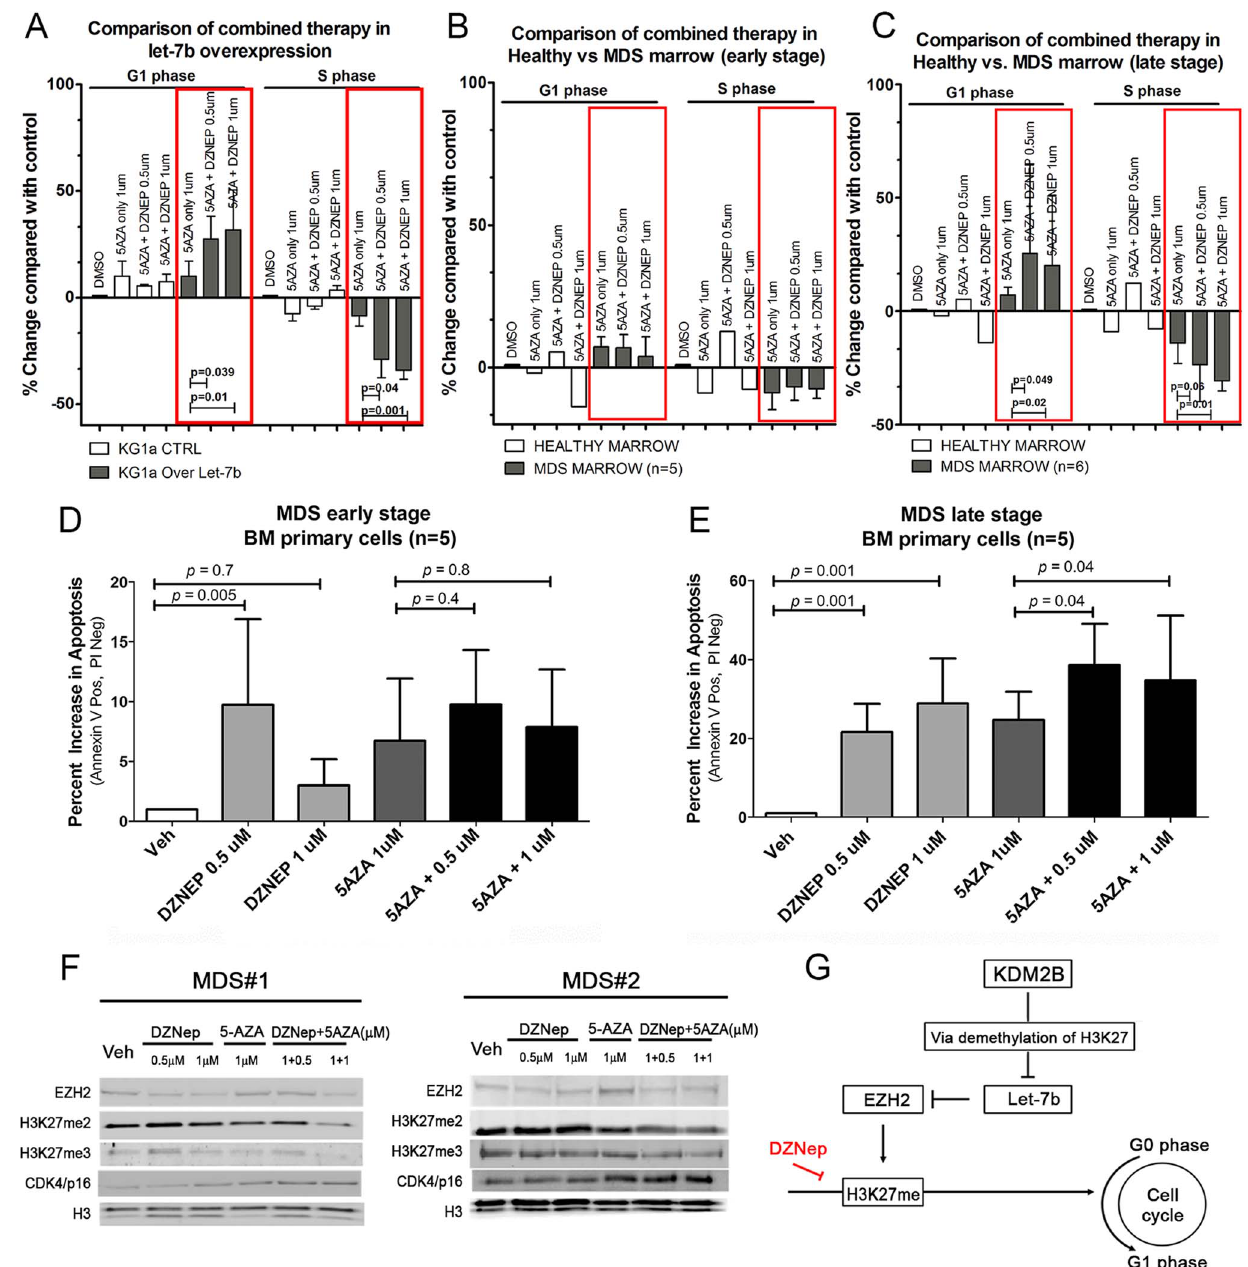
Figure 6. Response of cell lines and primary marrow cells to DZNep and 5AZA. Proliferation study in, A ) KG1a cells overexpressing let-7b, B ) primary marrow cells from healthy donors and MDS patients with , 10% marrow blasts, and C ) MDS patients with 10%–20% marrow myeloblasts. Exposure to DZNep, 5AZA or both affected the proliferation in KG1a cells overexpressing let-7b and cells from MDS marrows with 10%–20% but not in cells from patients with , 10% marrow blasts (or healthy donors). Exposure to DZNep, 5AZA or combination of both agents (inside of red boxes) affected the proliferation in KG1a cells overexpressing let-7b and cells from MDS marrows with 10–20% but not in cells from patients with , 10% marrow blasts or healthy donors. D ) and E ) show the extent of apoptosis induced by DZNep, 5AZA or both in MDS patients with , 10% and 10%– 20% marrow blasts, respectively. The extent of apoptosis was significantly greater in MDS marrows with higher myeloblast counts, more so in cells being treated with the drug combination than with single agents (p=0.04, 0.001). The results are displayed as mean 6 SEM for each MDS group (5 samples for , 10% marrow blasts and 6 samples for 10–20% marrow blasts) (Student t-test). F ) Two different primary BM CD34 + cells specimens showing decreased H3K27m2 and H3K27m3, and decreased EZH2 protein expression upon combined treatment with Dznep + 5AZA; Histone H3 served as nuclear loading control. G ) Working model: role of KDM2B/let-7b/EZH2 in epigenetic regulation of cell proliferation in MDS. KDM2B represses let-7b and up-regulates EZH2. DZnep treatment inhibits histone: H3K27; methylation and bypasses the KDM2B/let-7b/EZH2 effect leading to reduced cell proliferation.